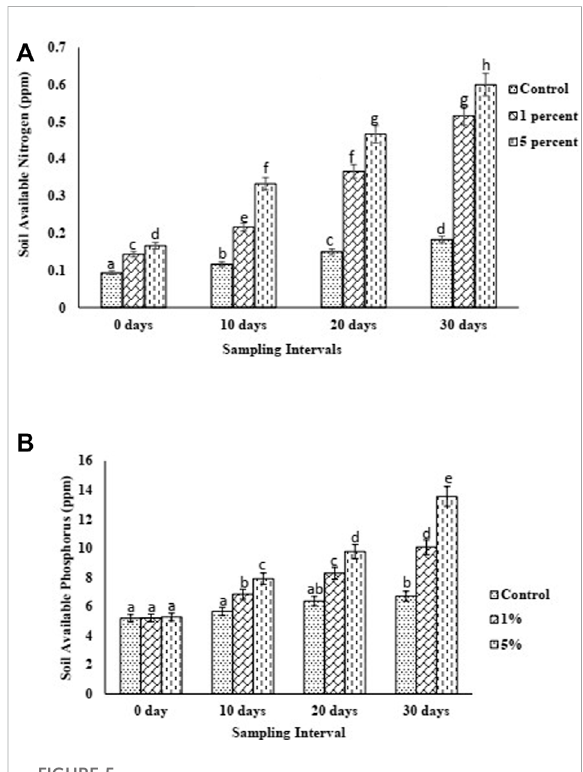
FIGURE 5 (A) Soilavailablenitrogen(SAN) (B) Soilavailablephosphorous (SAP) trend of control and biochar amended soils over 1 month